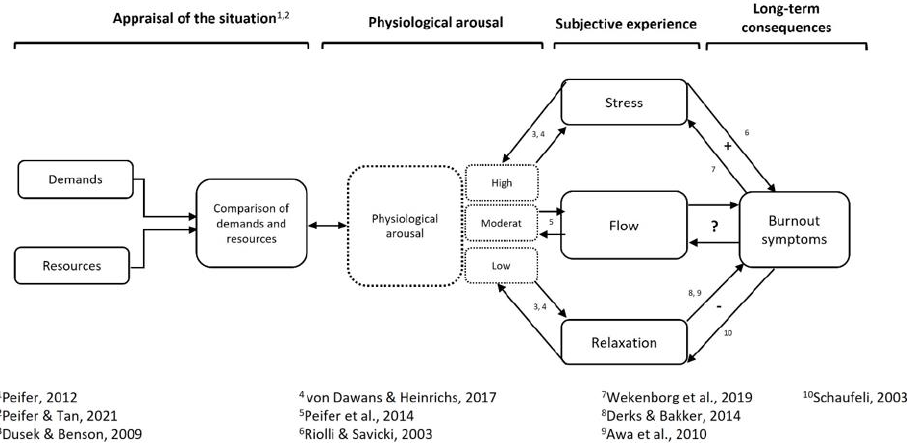
Figure 1. Initial Flow-Burnout-Model (adapted from Peifer & Tan [39], Peifer [42]). + = positive association; - = negative association.